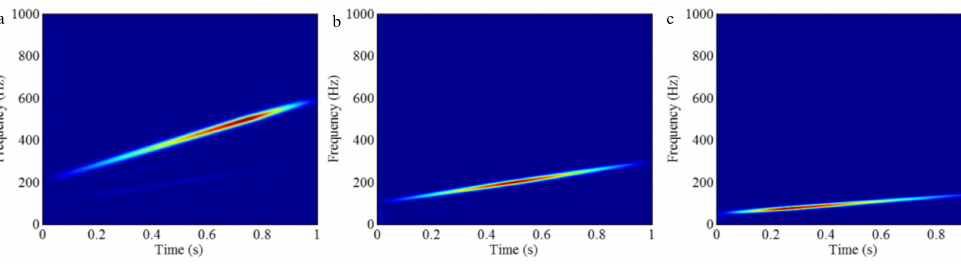
Figure 37. The decomposition result of f sig 6 by using EMD: ( a ) the waveform and ( b ) the Fourier spectrum.